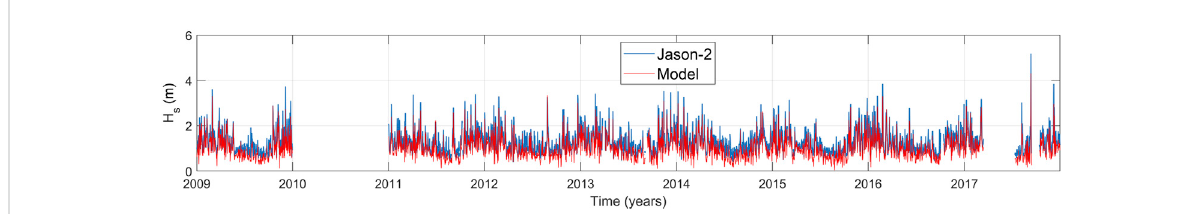
FIGURE 6 Time series of modelled and measured signi fi cant wave heights from the Jason-2 satellite.